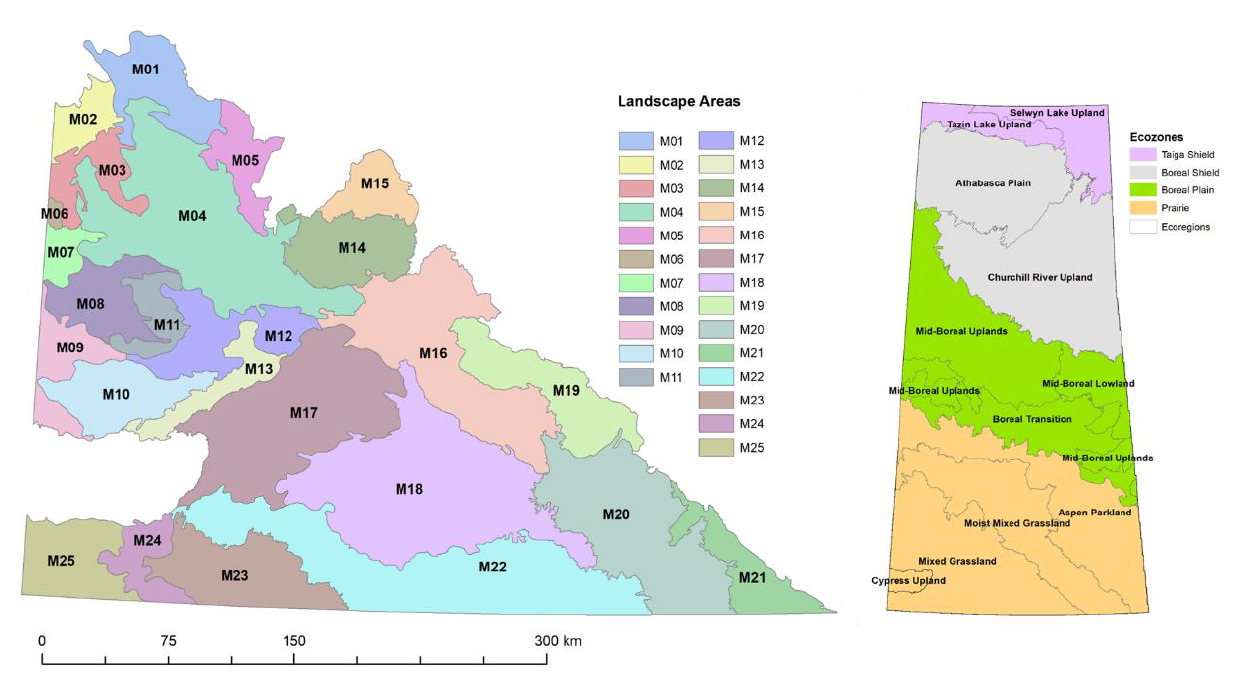
Figure 1. The geographical location of the case study (MGE) in Saskatchewan and landscape areas (M#); M1 Kerrobert Plain; M2 Sibbald Plain; M3 Oyen Upland; M4 Eston Plain; M5 Bad Hills; M6 Acadia Valley Plain; M7 Bindloss Plain; M8 Hazlet Plain; M9 Schuler Plain; Maple Creek Plain; M11 Great Sand Hills; M12 Antelope Creek Plain; M13 Gull Lake Plain; M14 Beechy Hills; M15 Coteau Hills; M16 Chaplin Plain; M17 Swift Current Plateau; M18 Wood River Plain; M19 Dirt Hills; M20 Coteau Lakes Upland; M21 Lake Alma Upland; M22 Wood Mountain Plateau; M23 Climax Plain; M24 Wild Horse Plain; M25 Old Man on His Back Plateau. Table 1. The definitions of the classes that were chosen in the PLI project for field survey and mapping. Class